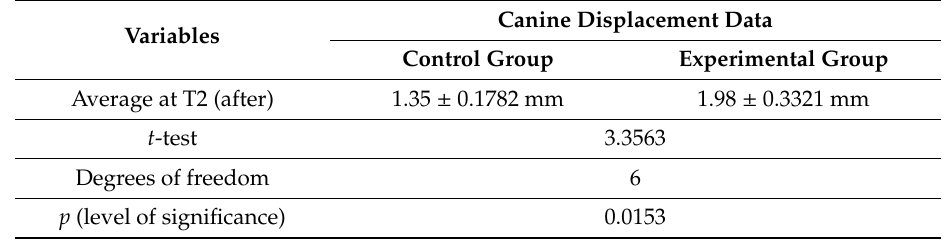
Table 2. Average Distal Displacement Entity of Canines (mm) after 1 Month of Follow-Up (Di ff erence T0 − T2).